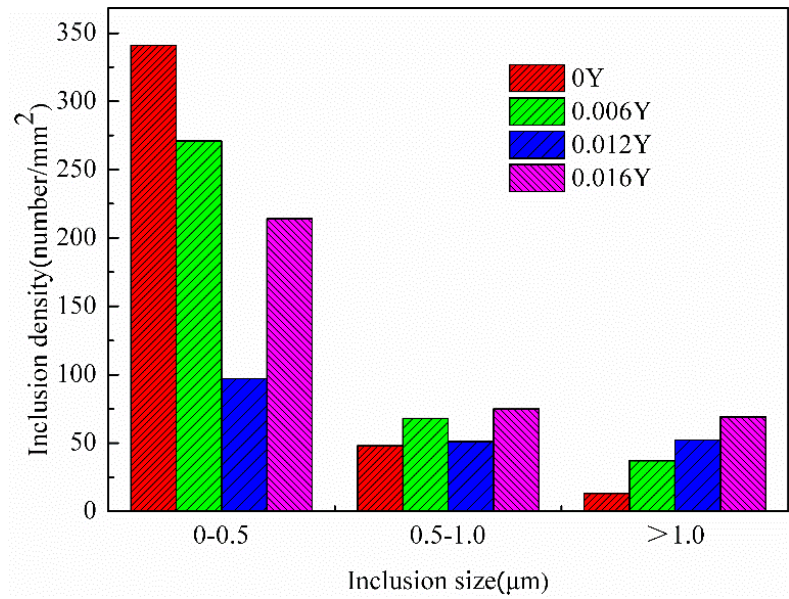
Figure 8. The inclusion size distribution of final sheets with different Y